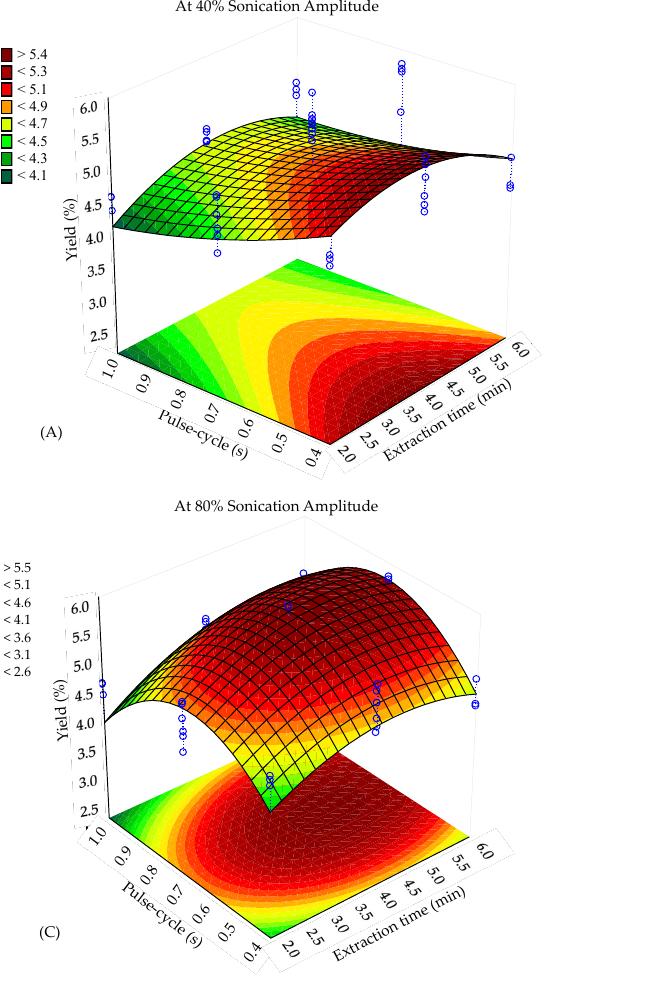
Figure 2. Response surface plots indicating the effect of ultrasound-assisted extraction on Yield (%) of phenolic compounds from A. muricata leaves using 40% ( A ), 60% ( B ), and 80% ( C ) of sonication amplitude and Pareto chart ( D ). X TE = extraction time. X PC = pulse cycle. X SA = sonication amplitude. Table 2. Optimal conditions by ultrasonic-assisted extraction of total soluble phenols and yield from the extract of Annona muricata leaves obtained by the predicted